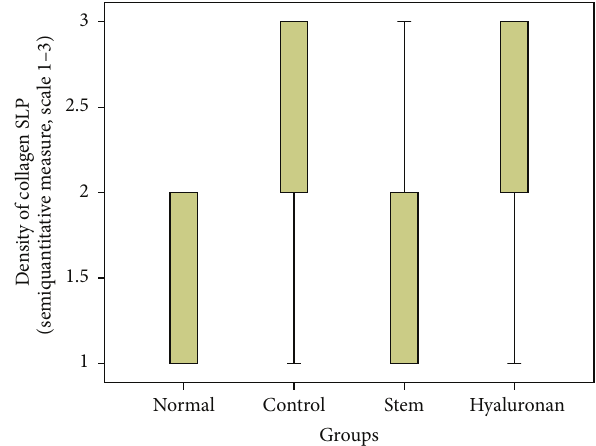
Figure 13: Mean thickness (mm) of the lamina propria (LP), through the different treatment groups. Normal = normal/control group, control = scarred/control group, stem = stem cell group, and hyaluronan = hyaluronan group.